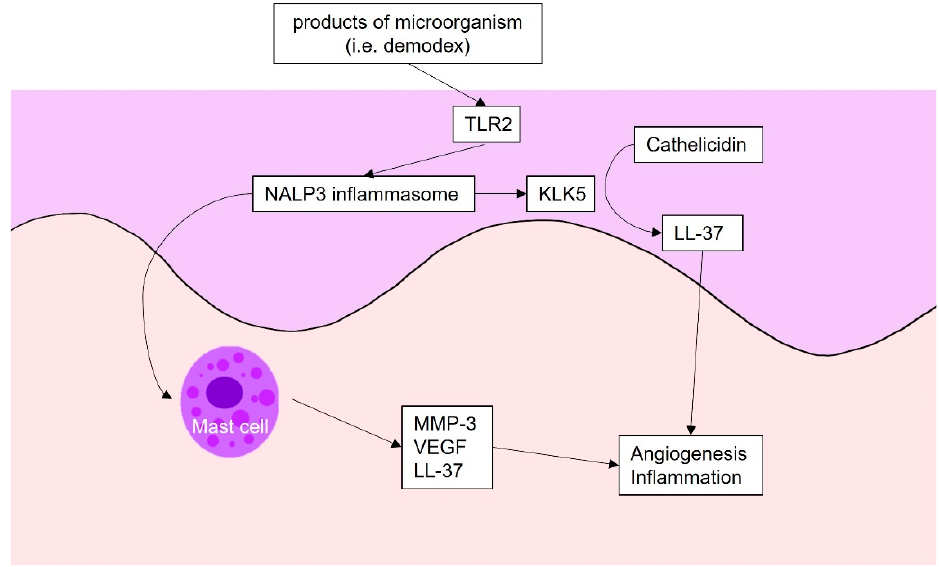
Figure 3. Angiogenesis in rosacea: The products of microbes are recognized by TLR 2. Subsequently, TLR 2 activates NALP3 inflammasome, which triggers kallikrein 5. Kallikrein 5 cleaves cathelicidin into LL-37, which triggers angiogenesis and inflammation. NALP3 inflammasome also activates mast cells, which produce inflammatory and angiogenetic factors, such as VEGF. TLR2, Toll-like receptor 2; KLK5, kallikrein5; MMP, metalloproteinase; VEGF, vascular endothelial growth factor.